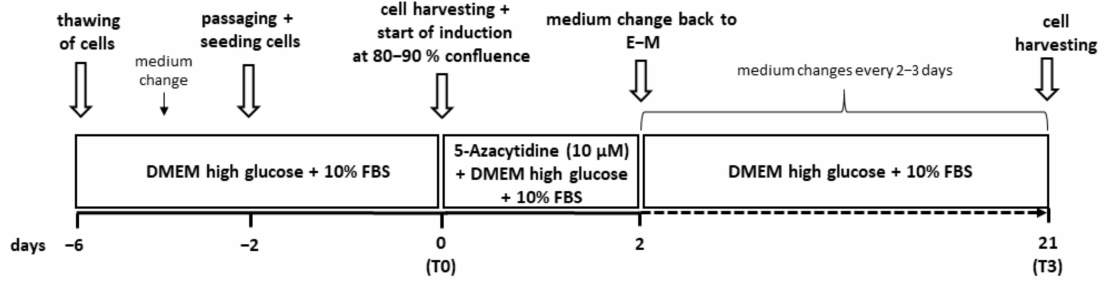
Figure 1. Timeline showing the protocol for the induction experiment with 5-azacytidine (5-AZA). E-M, expansion medium; FBS, fetal bovine serum; DMEM, Dulbecco’s Modified Eagle Medium. At this time point (T3), the expression of pluripotency and cardiac markers was non-induced abd ASCs- SVF at day 0 (T0). Untreated control cells cultivated in E-M until T3 served as negative controls (nc). Cells were cultivated in uncoated 75 cm 2 cell culture flasks (tissue culture flask 75, TPP Techno Plastic Products AG, Trasadingen, Switzerland). Cell morphology (CM appearance, spontaneous beating of cells) was subjectively